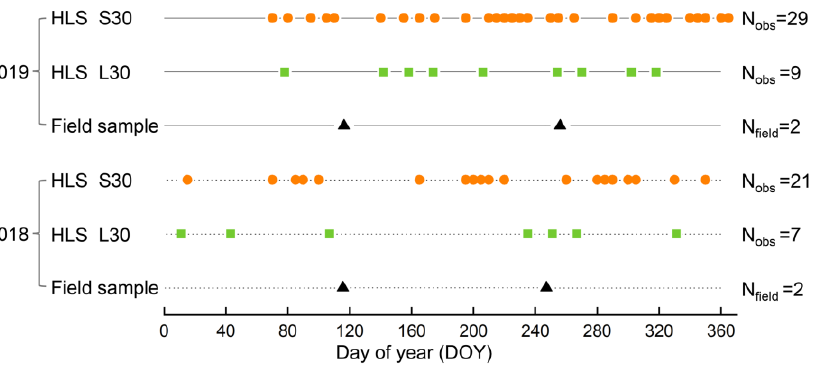
Figure 2. The numbers (N obs ) and observation dates of high-quality HLS S30 (circle points) and L30 (square points) products obtained over the study area in 2019 and 2018. The crop samples collected from two field surveys (N field = 2) and the specific date of each field survey (triangle points) were also displayed in this figure.